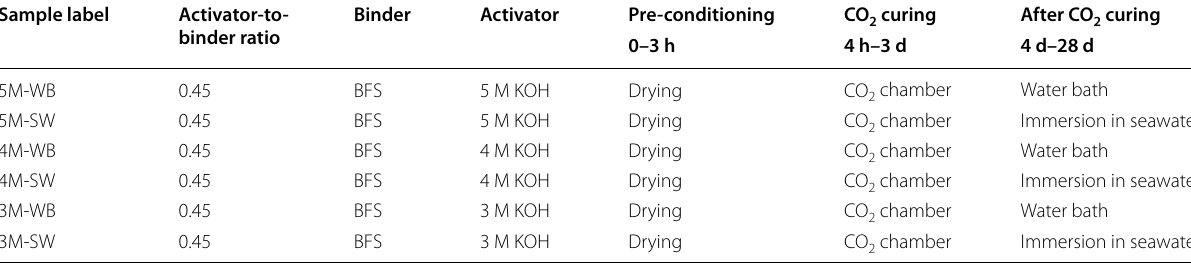
Table 3 Mix proportions and experimental sequence for samples Sample